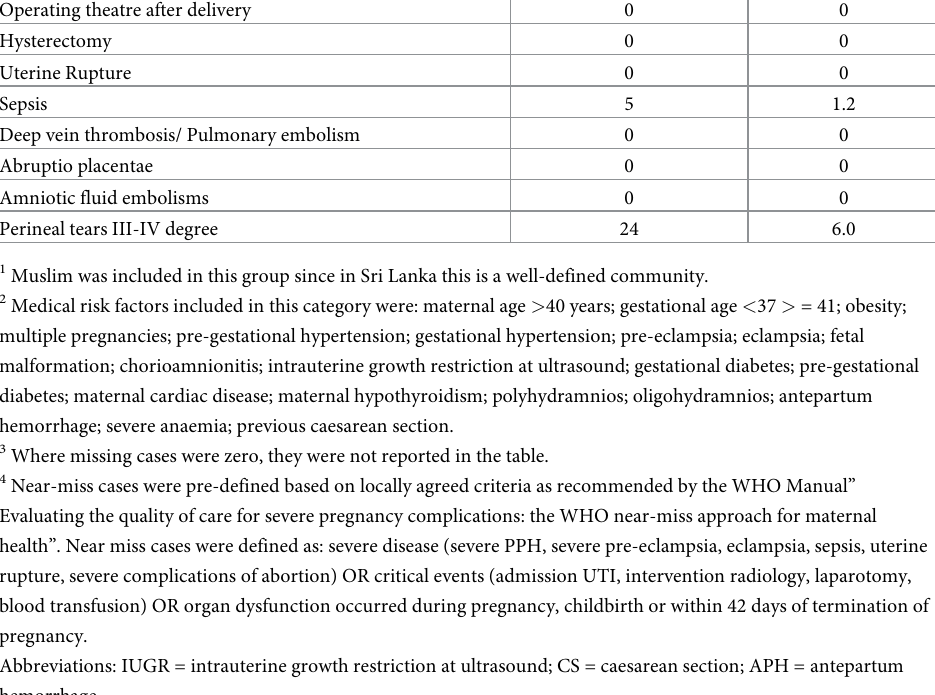
Frequencies of each of the 30 items on the PCMC scale is detailed in S4 Table . About two thirds of women (63.5%) reported that medical staff treated them with respect even though the majority (99.3%) reported to have been treated in an unfriendly manner. Overall, one out of six (14.8%) felt to have been treated roughly—pushed, beaten, slapped, pinched, physically restrained, or gagged—and nearly one third (28.5%) reported to have been shouted at, scolded, insulted, threatened, or talked to rudely. Most women (85.8%) reported that health profession- als did not explain drugs that were administered, and more than half (55%) did not